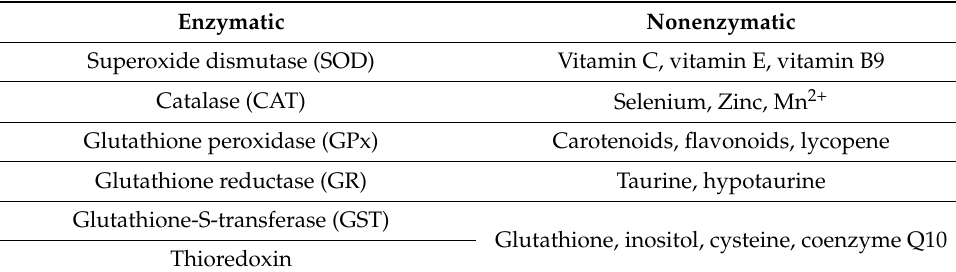
Table 1. Enzymatic and nonenzymatic